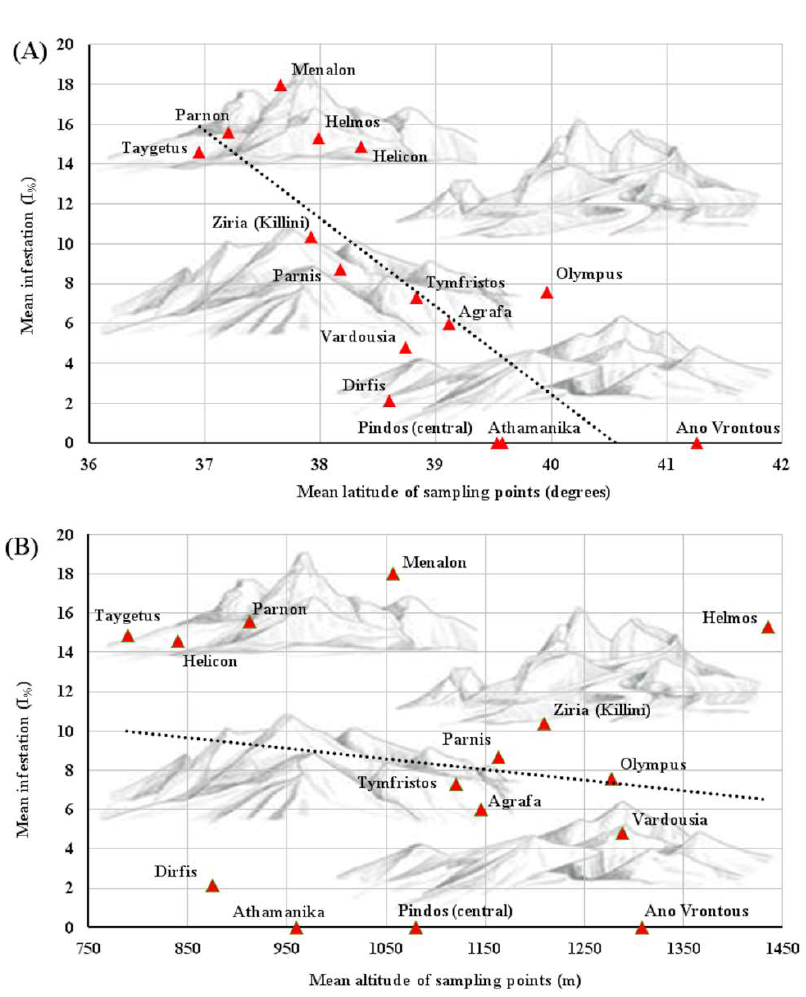
Figure 2. Percentage infestation [I (%) ] of fir tree ( Abies spp.) samples by P. hellenicus , per sampled mountain, against latitude ( A ) and altitude ( B ) of sampling points at different mountains of Greece.